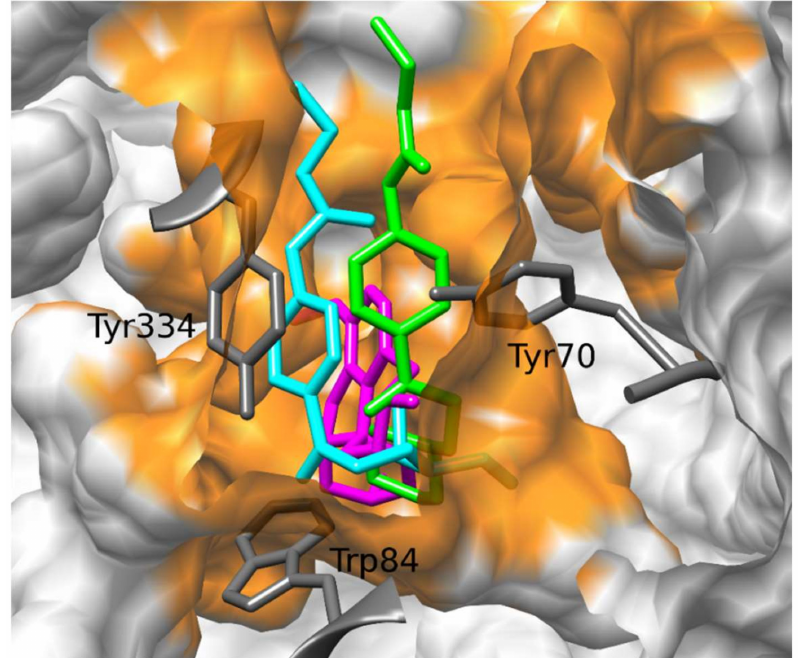
Figure 1. Spatial view of the compounds bonded in the binding pocket of AChE (PDB code: 1DX6). Compounds 3 (green) and 6 (light blue) are superimposed on galantamine (magenta). Some